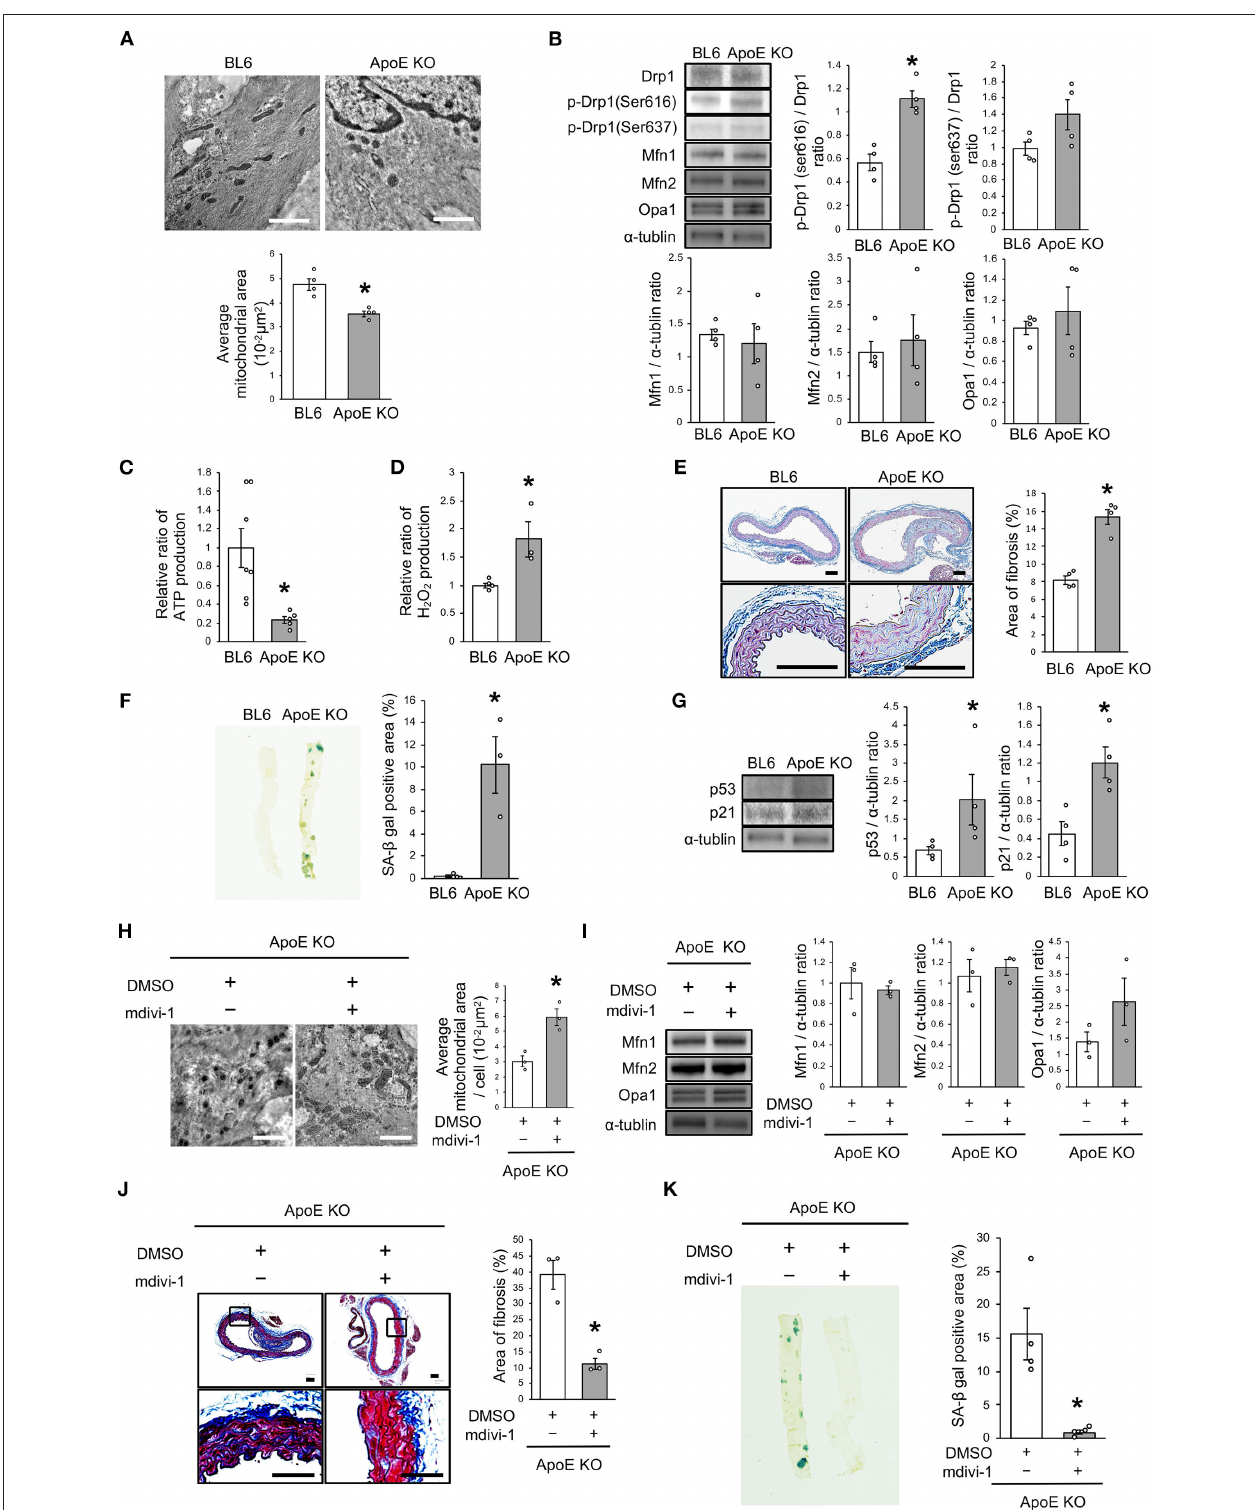
FIGURE 7 | Drp1 inhibition improved the imbalance of excessive mitochondrial fission and vascular senescence in ApoE KO mice. (A) Electron microscopic images and quantitative analysis of mitochondria and average mitochondrial areas in C57BL/6 and ApoE KO mice. Scale bar = 1 µ m. * P < 0.05 vs. C57BL/6 ( n = 4